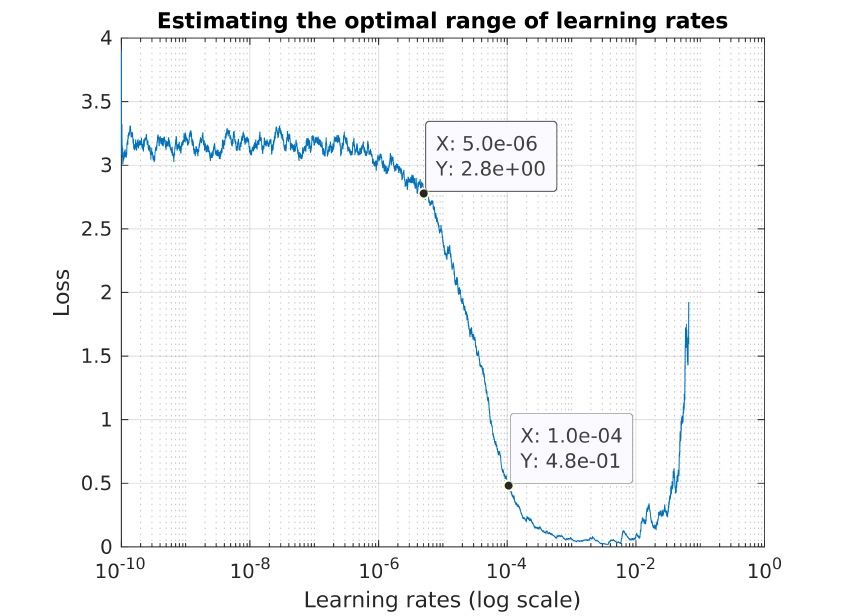
Figure 4. Finding the optimal learning rate range to use in the cyclical learning rate